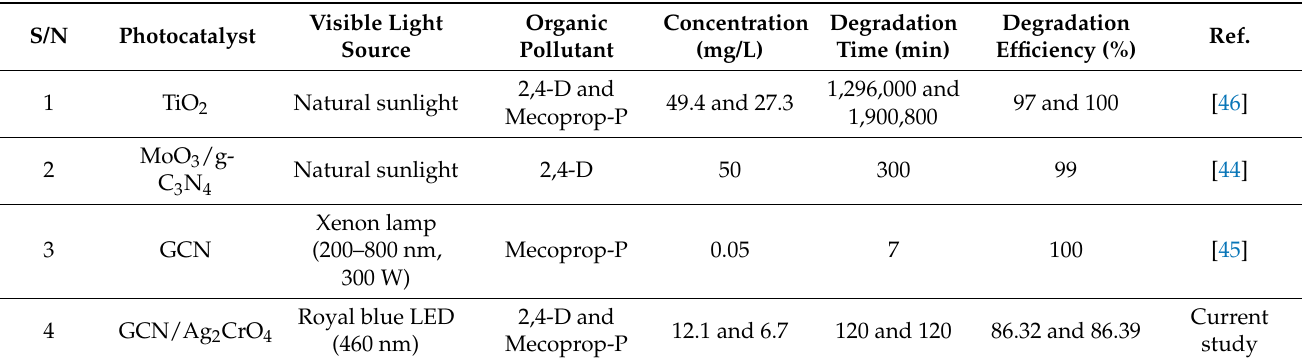
Table 3. Comparison of 2,4-D and Mecoprop-P degradation with the results of previously published